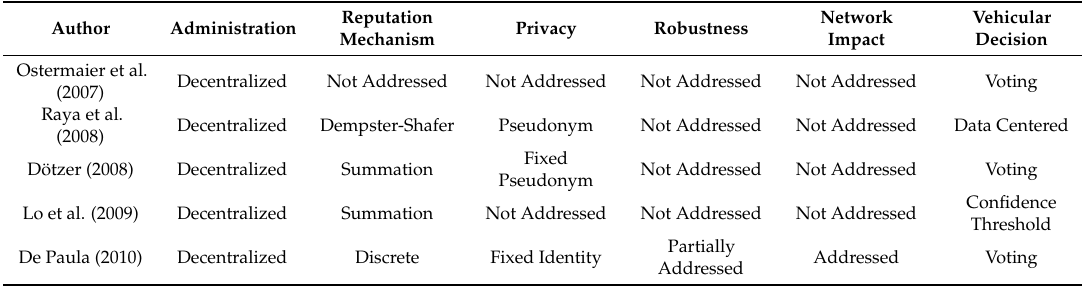
Table 1. Qualitative comparison of